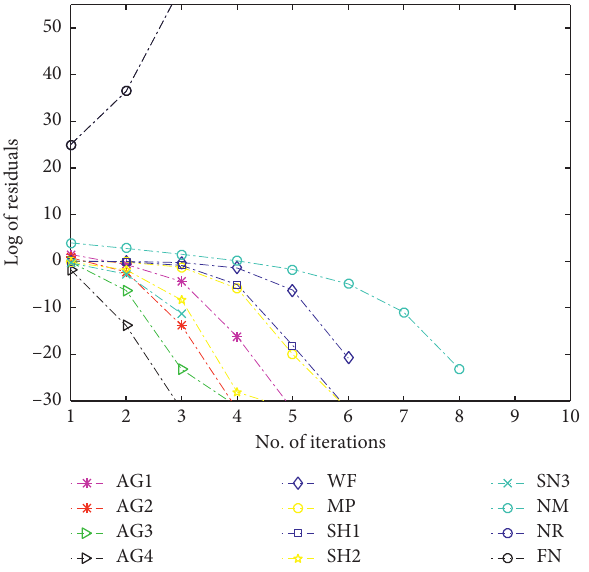
Figure 3: Log of residuals for equation